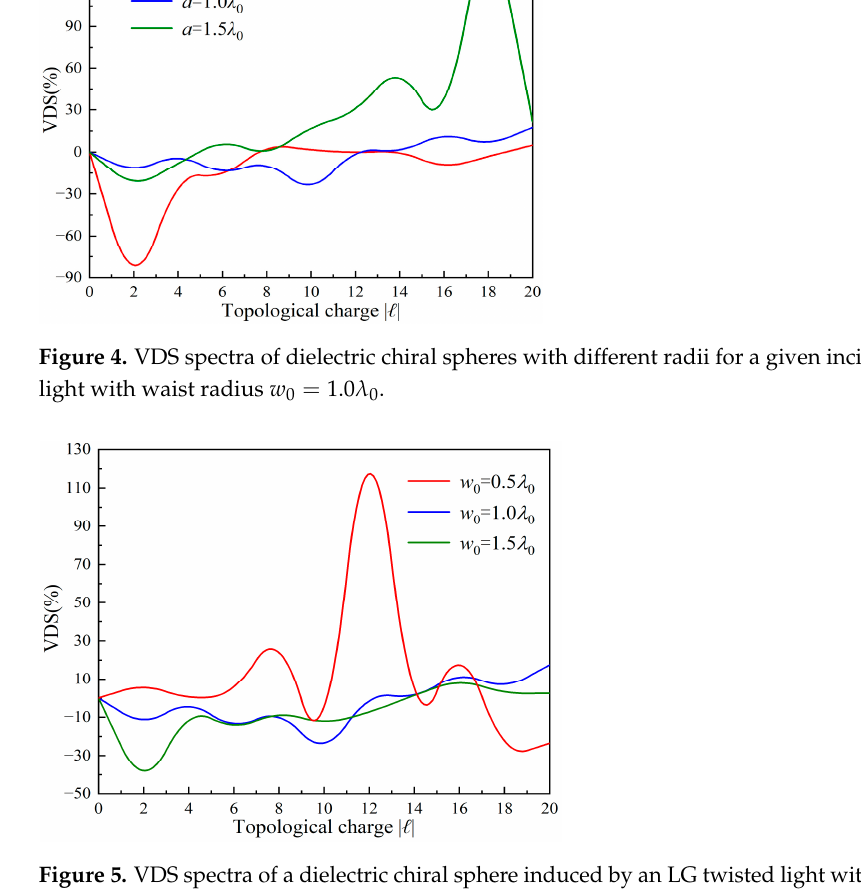
Figure 5. VDS spectra of a dielectric chiral sphere induced by an LG twisted light with different waist